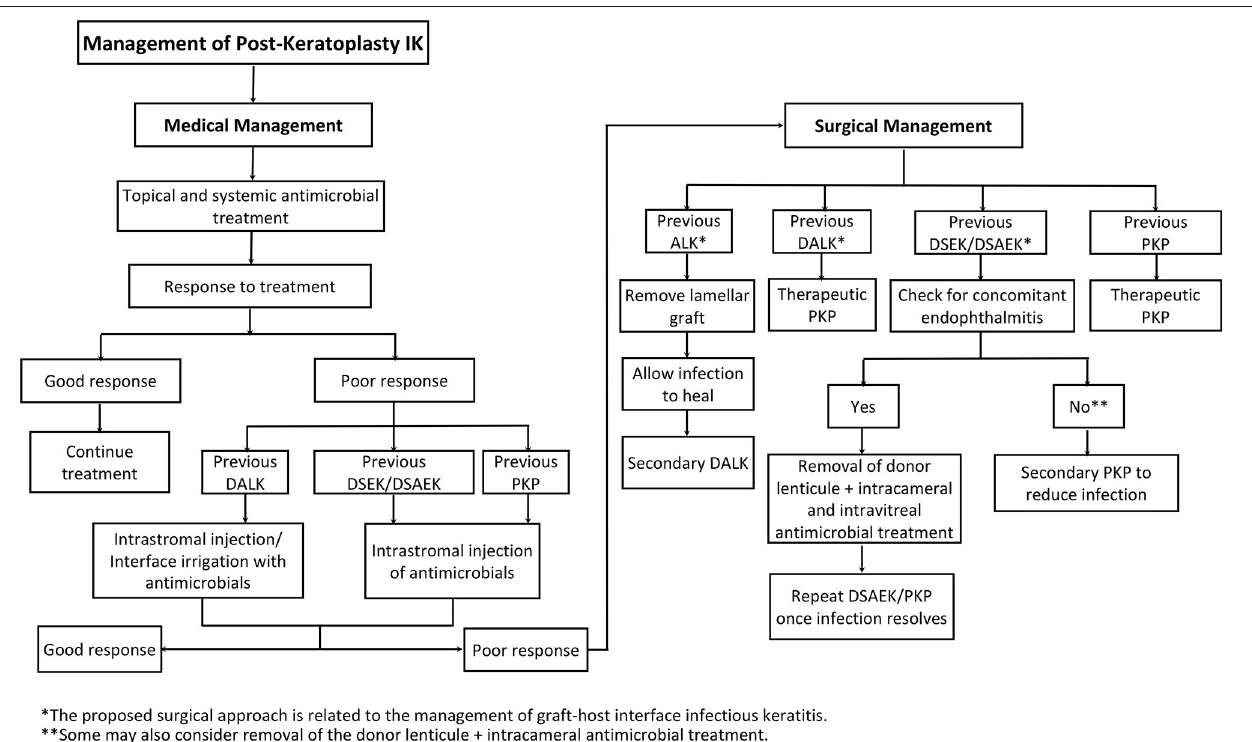
FIGURE 3 | A proposed systematic treatment algorithm of post-keratoplasty infectious keratitis (PKIK). *The proposed surgical approach is related to the management of graft-host interface infectious keratitis. **Some may also consider removal of the donor lenticule + intracameral antimicrobial